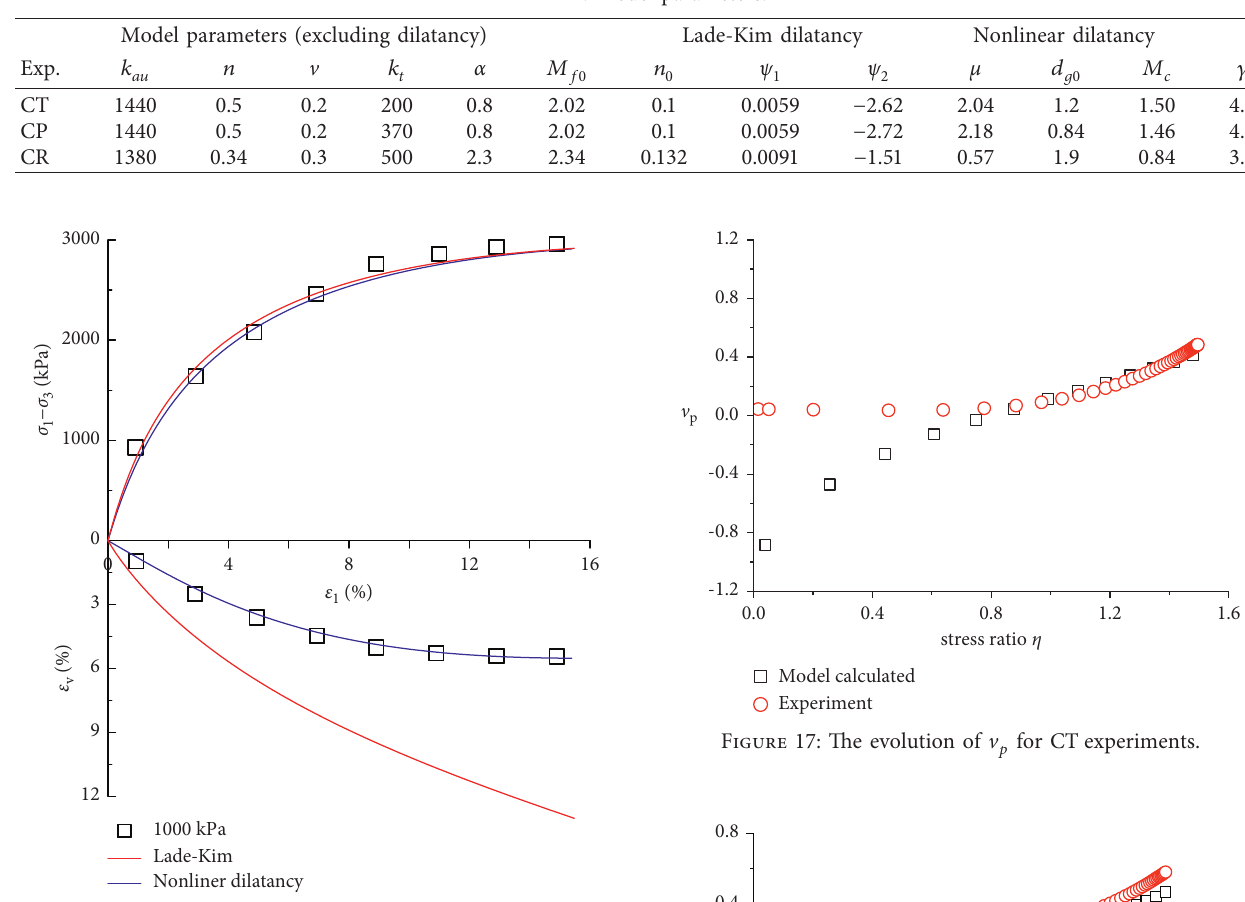
Table 1: Model parameters.